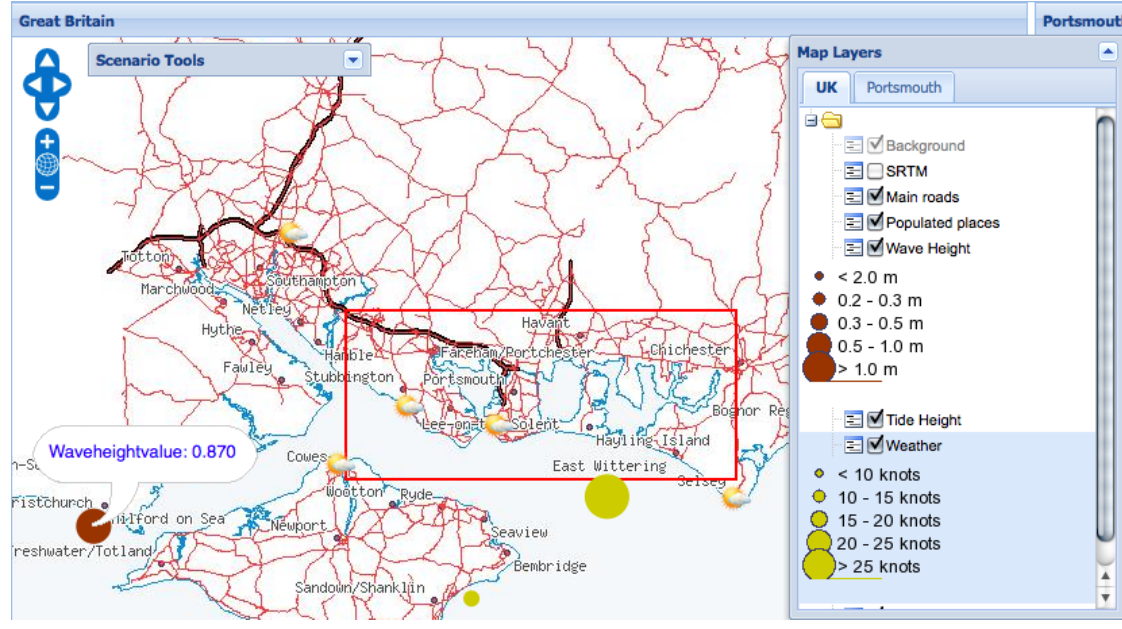
Figure 10. Screenshot showing layers generated from sensor readings.